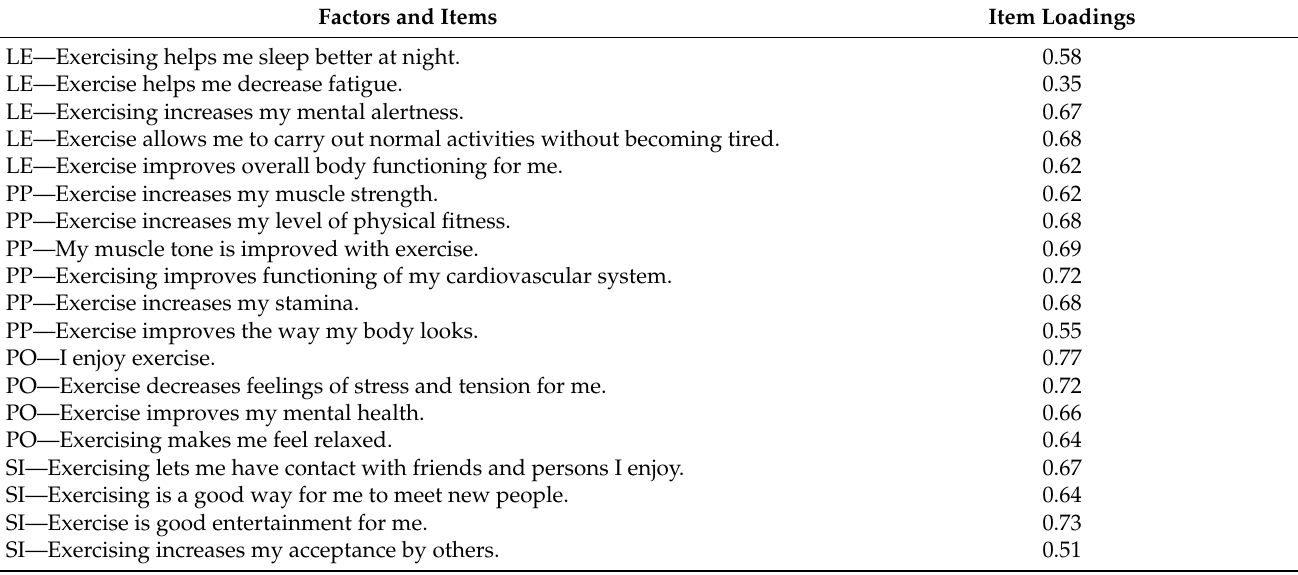
Table 5. Benefits—retained items and factor